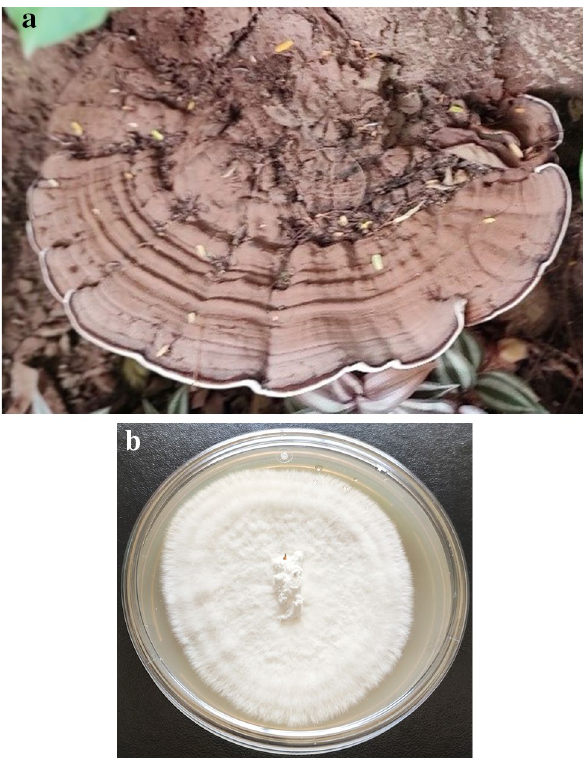
Figure 2. Morphological representation of basidiocarp of GPC191 ( a ) Mature basidiocarp in the field; ( b ) culture plate at 240